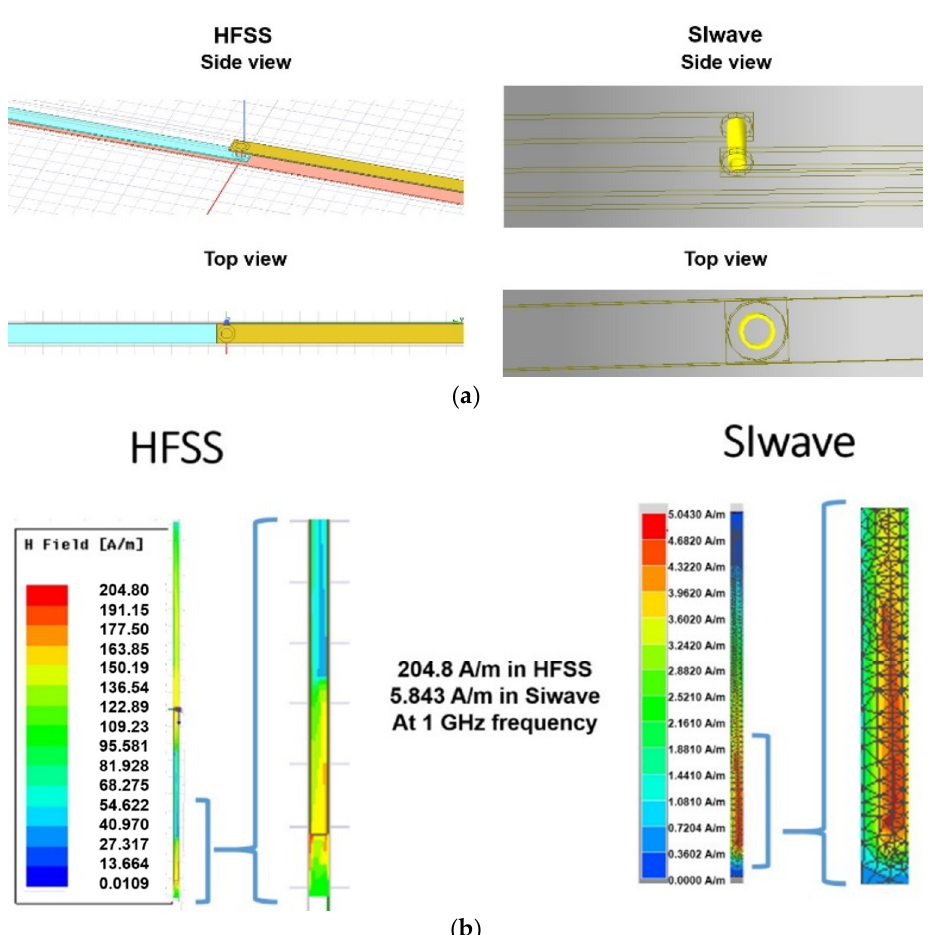
Figure 5. Comparison of method of moments (MOM) and finite element method (FEM) simulation: ( a ) side and top view of test structure used for simulation, ( b ) magnetic field distribution in HFSS (3D method) and SIwave (2.5D method) software,